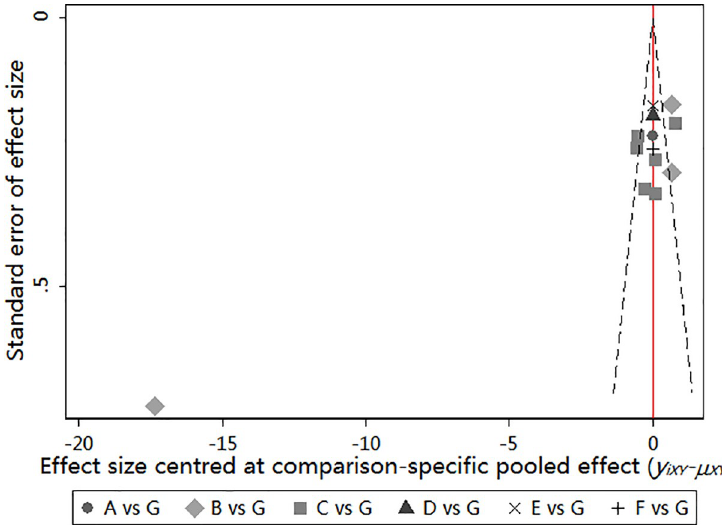
Fig 6. A: mechanical ventilation � 24h; B: mechanical ventilation with 24h-48h; C: mechanical ventilation with 48h- 72h; D: mechanical ventilation > 96h; E: ICU admitted > 5days; F: ICU admitted > 7days; G: Usual care.